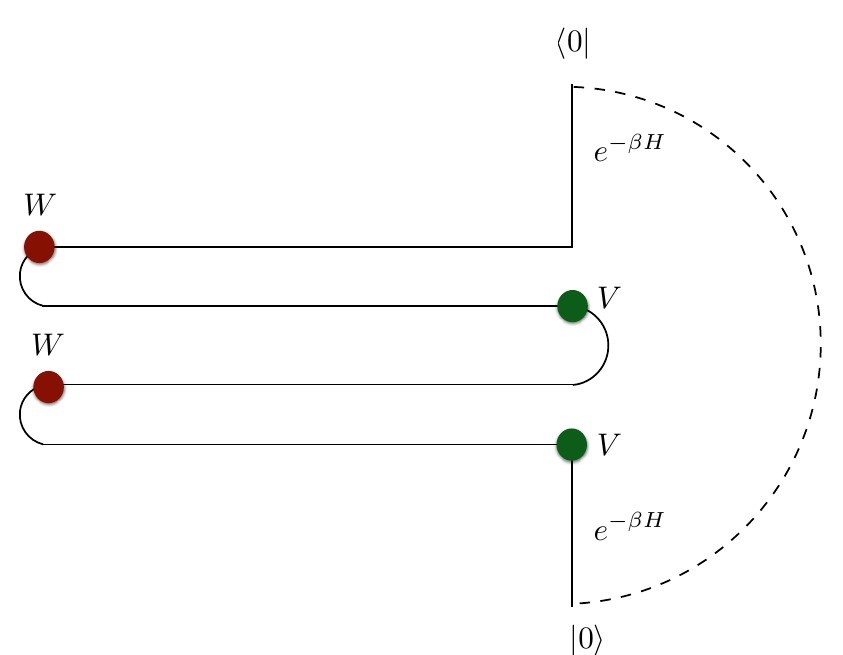
Figure 3 . A demonstration of the Schwinger-Keldysh contour on which the four-point OTOC is calculated. The solid dots denote an insertion of the corresponding